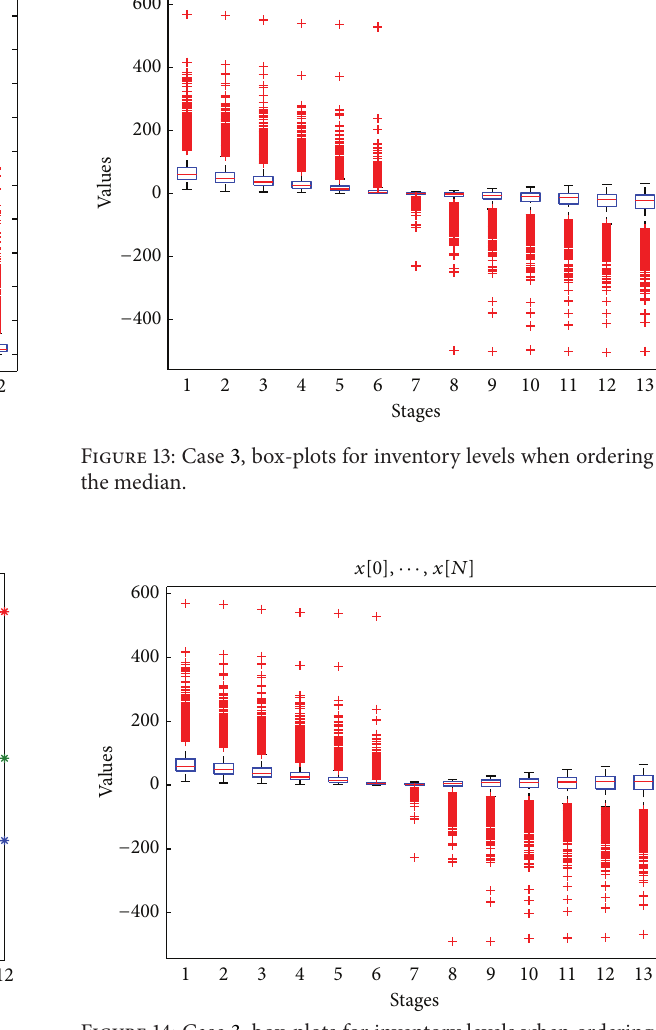
Figure 14: Case 3, box-plots for inventory levels when ordering by 70th percentile.